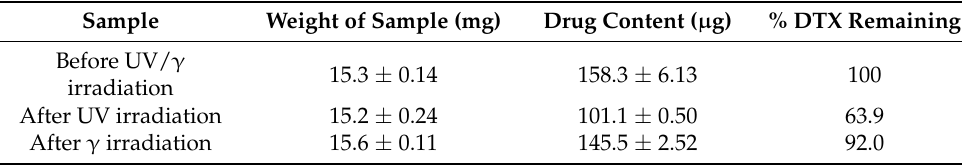
Table 3. Effect of gamma and UV irradiation on drug content of DTX loaded stents.